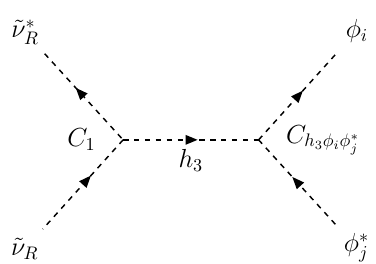
Figure 2. Main annihilation process for the annihilation of RH sneutrinos. The (cid:12)nal state can contain both physical Higgs particles and the longitudinal components of the weak W and Z gauge bosons, which are equivalent to the corresponding would-be Goldstone